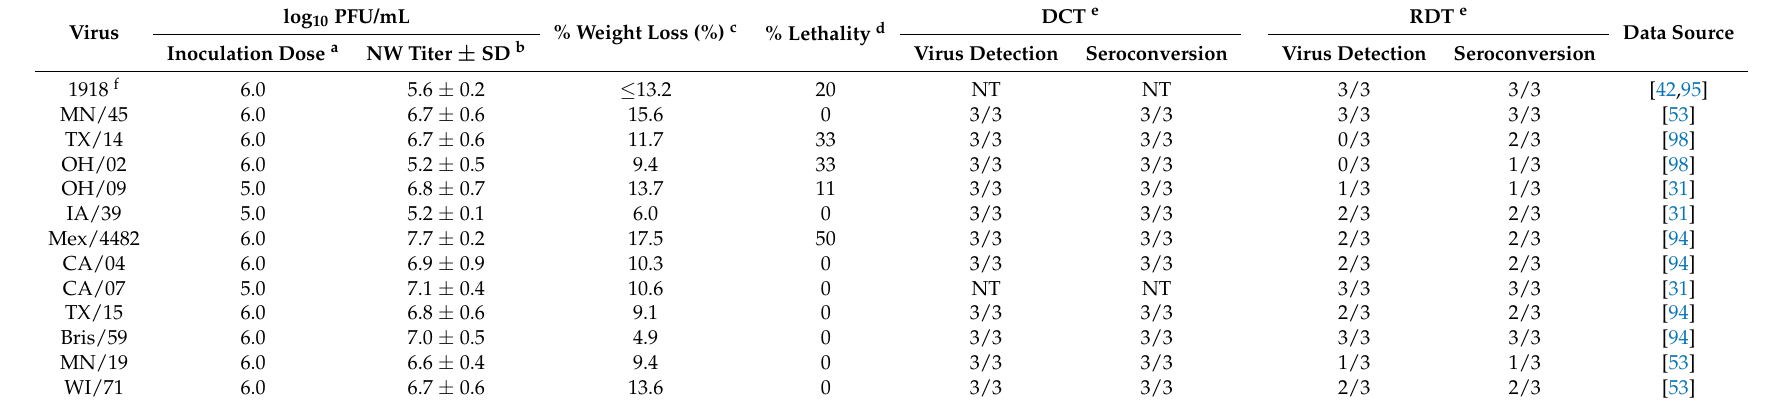
Table 4. Pathogenicity and transmissibility of H1 influenza viruses in